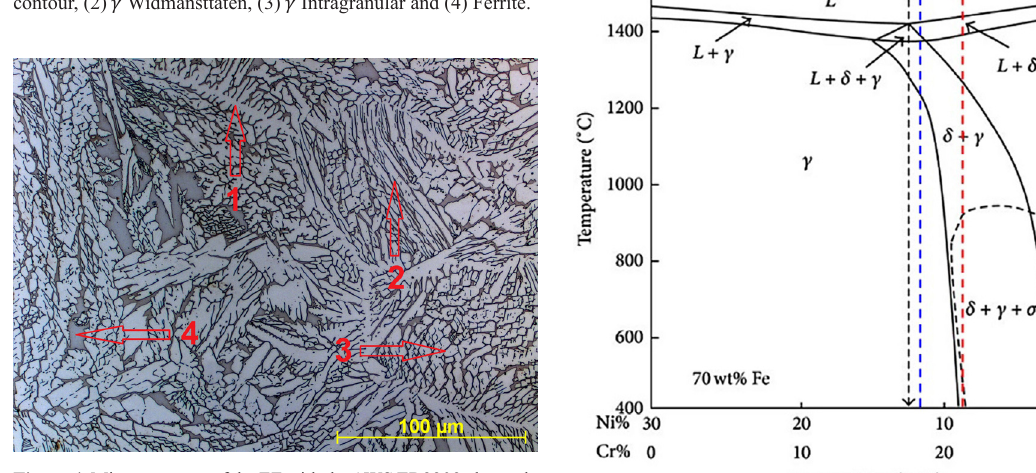
Figure 4. Microstructure of the FZ with the AWS ER2209 electrode using of 8 KJ / cm. Highlight for points (1)